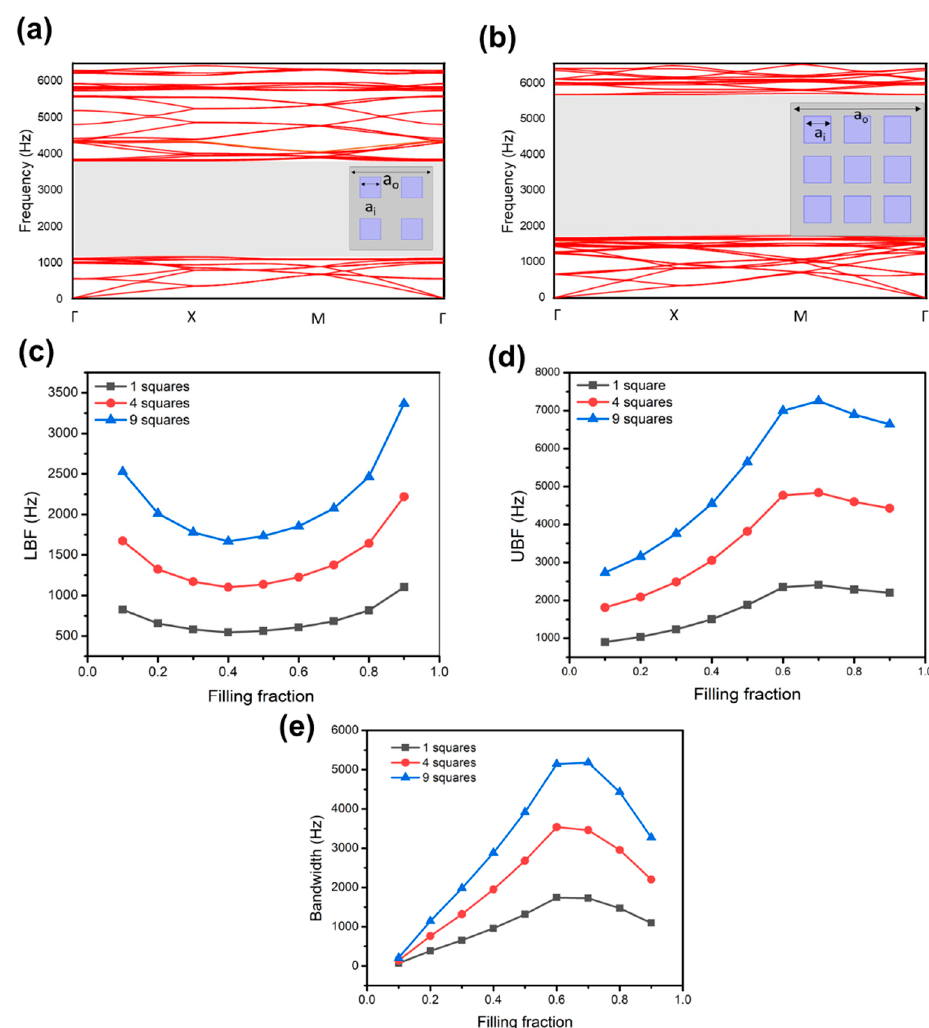
Figure 2. ( a ) The dispersion curves generated for a phononic crystal with four-square inclusions with FF = 0.5. ( b ) The dispersion curves generated for a phononic crystal with nine-square inclusions with FF = 0.5. ( c – e ) lower bound frequency (LBF), upper bound frequency (UBF), and bandwidth versus filling fraction for different unit cells with one-, four-, and nine-square